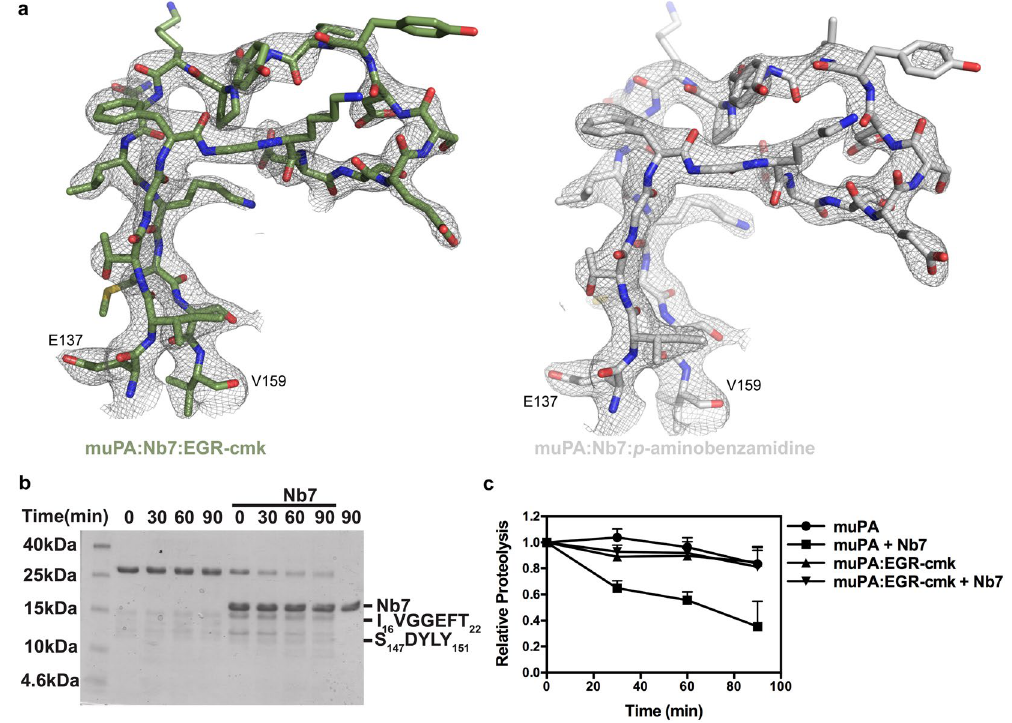
Figure 6. Effect of Nb7 and substrate-like molecules on the conformational flexibility of the 140s loop. ( a ) Superposition of the structure around the 140s loop with the 2 F o – F c electron density map at contour level σ = 1 (grey) after soaking crystals containing the muPA:Nb7 complex with EGR-cmk (green) or p -aminobenzamidine (white). ( b ) An example of a SDS-PAGE analysis of full-length muPA in the absence or presence of Nb7 and the protease Glu-C. The N-terminal sequences of the two pronounced bands at 12 kDa and 15 kDa are indicated to the right. ( c ) Quantification by densitometry of the band corresponding to the intact catalytic domain of muPA (28 kDa) in the absence or presence of Nb7 and/or EGR-cmk. Error bars, s.d. (n = 3 independent